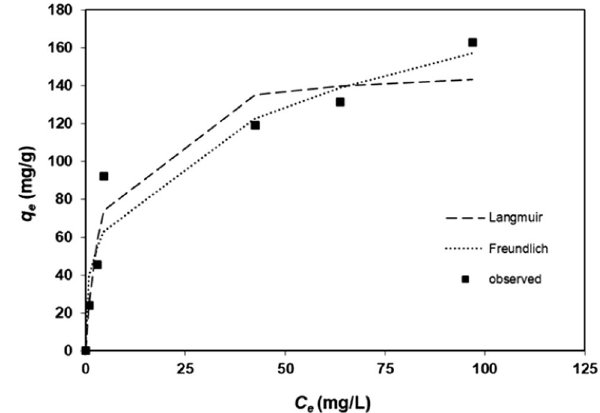
Fig. 6 Nonlinear adsorption isotherm plots of Langmuir and Freun- dlich models for MB adsorption on BNH-CM surface at 40